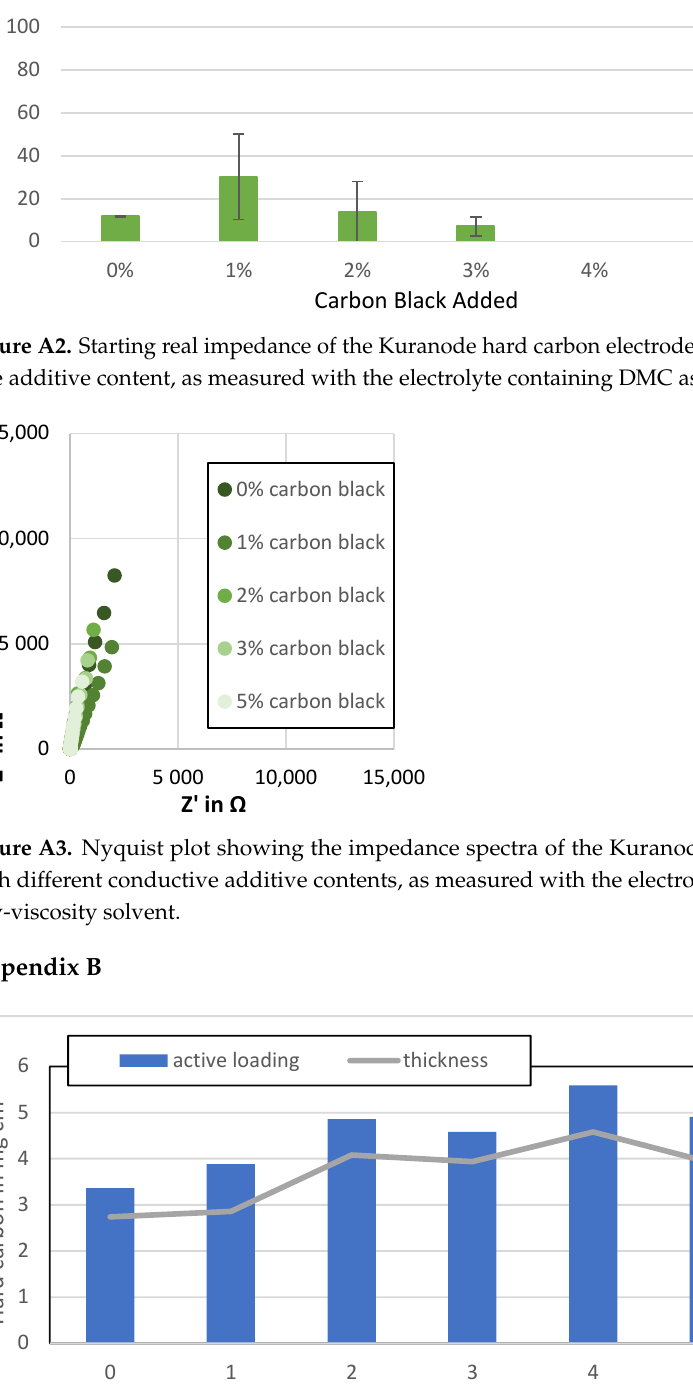
Figure A5. Active material loading of the MTI anodes mixed at 1500 rpm. Figure A6. Active material loading of the MTI anodes mixed at 3500 rpm.